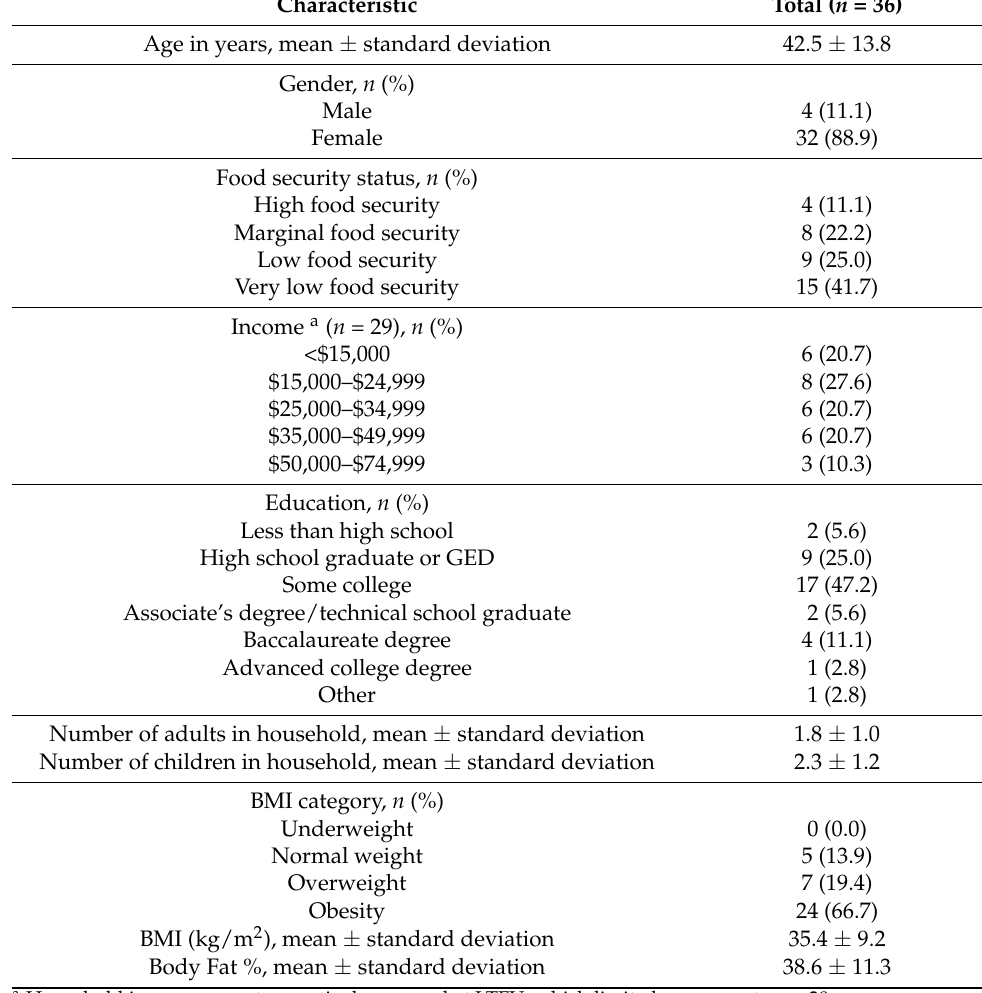
Table 1. Participant Sociodemographic and Health